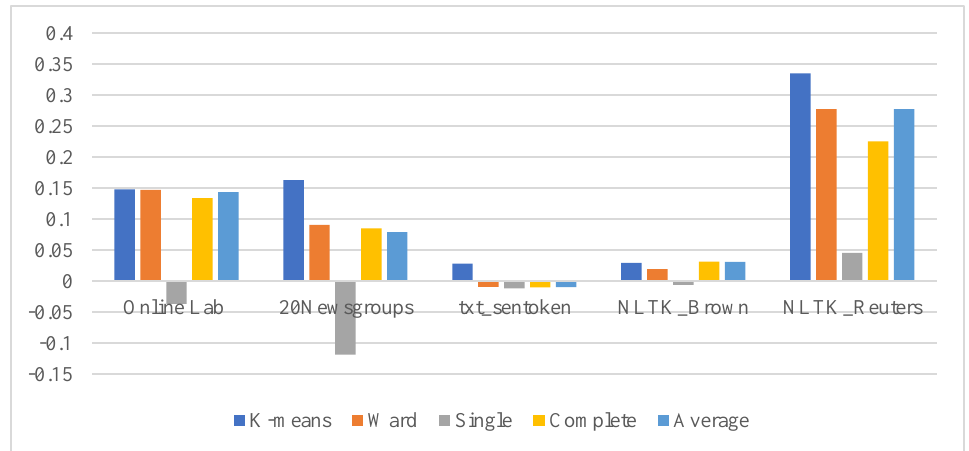
Figure 9. Similarity ratio preprocessing without stemming (PPWoS).